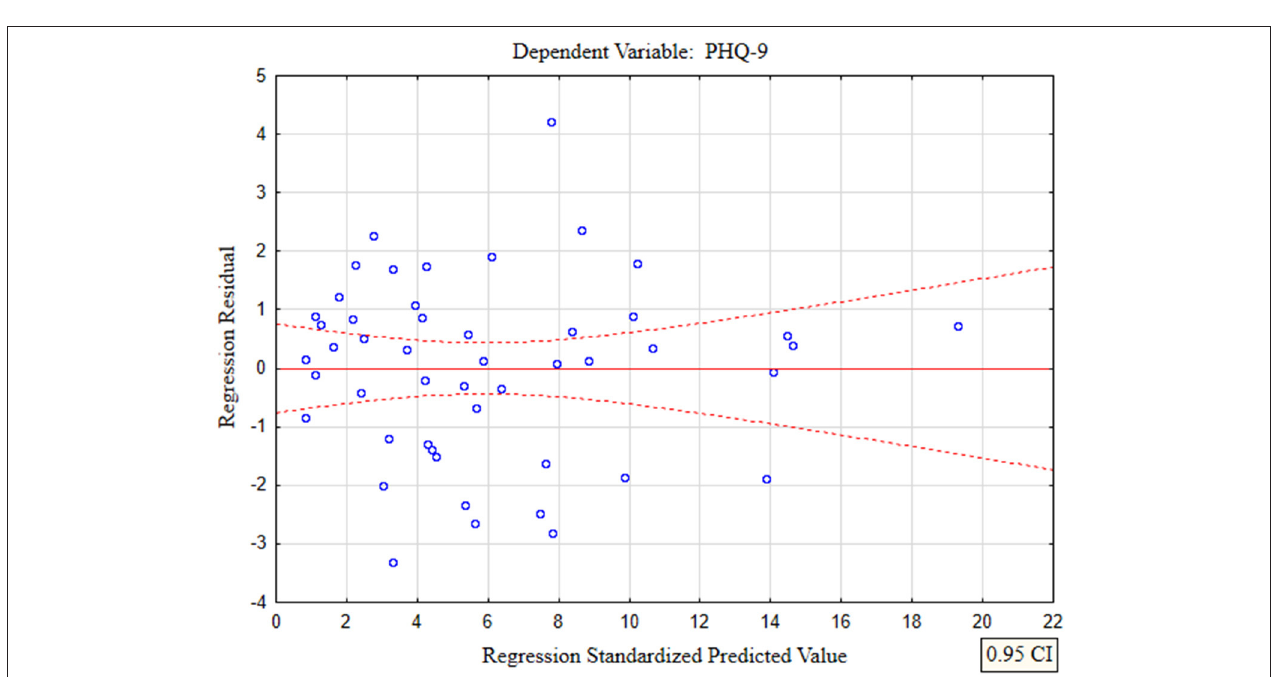
FIGURE 1 | The plot of standardized residues vs. standardized predicted values (homoscedasticity) with respect to multiple linear regression model for PHQ-9 estimation. 121.38; p < 0.00], as in the former the average error in evaluating the level of GAD-7 was SE = 1.7674 ( Table 5